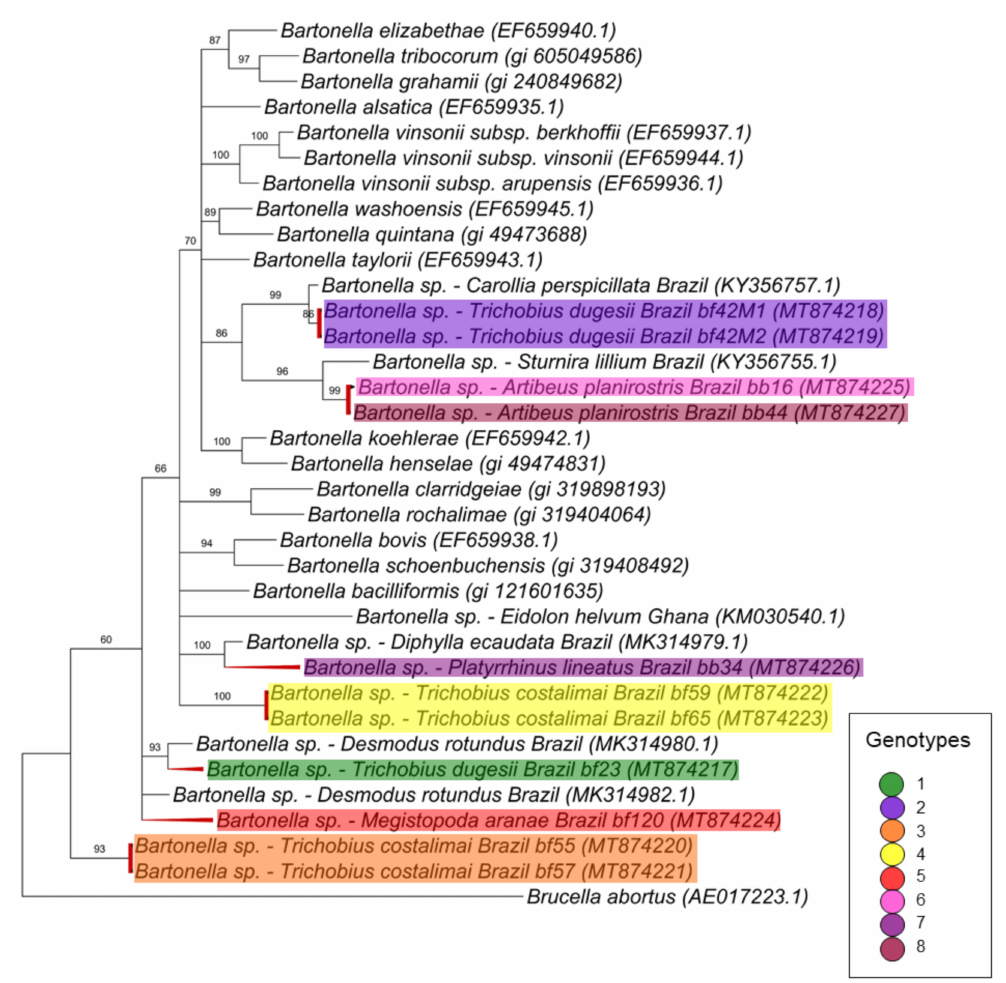
Figure 4. Phylogenetic tree based on an alignment of 368 bp-length of Bartonella spp. nuoG sequences, using the Bayesian Inference method and TIM2ef + I + G as the evolutionary model. Numbers at nodes correspond to the posterior probability value support. Each sequence is highlighted according to its respective genotype. Each sample is designated with the type of sample (bb = bat blood and bf = bat fly) followed by the referred animal